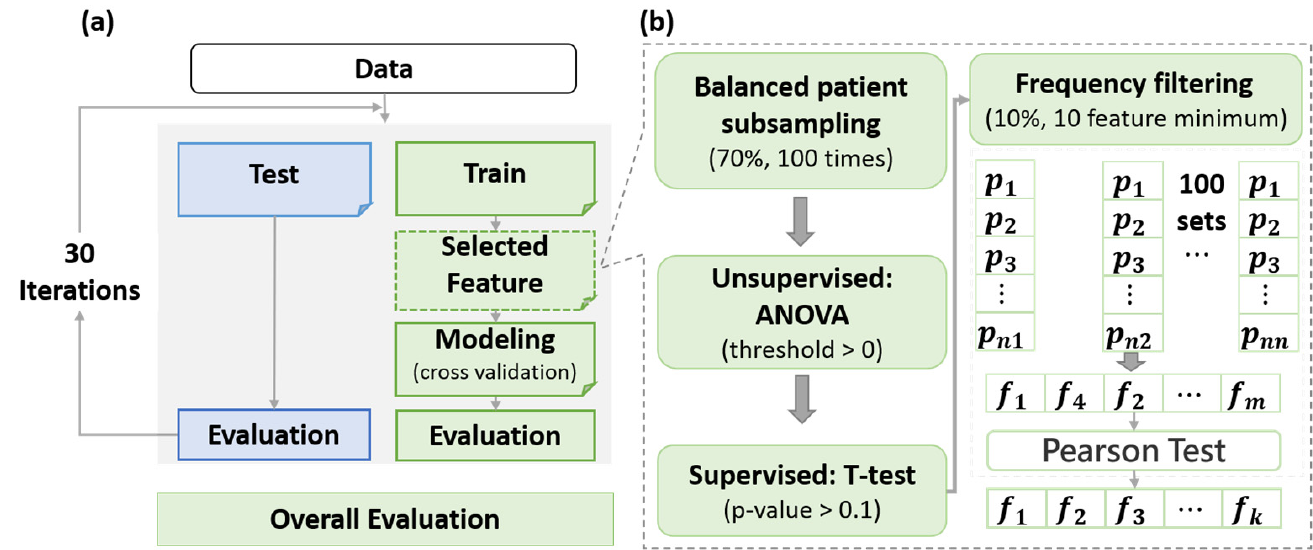
Figure 3. The flowchart of ( a ) classification model construction and ( b ) feature selection.